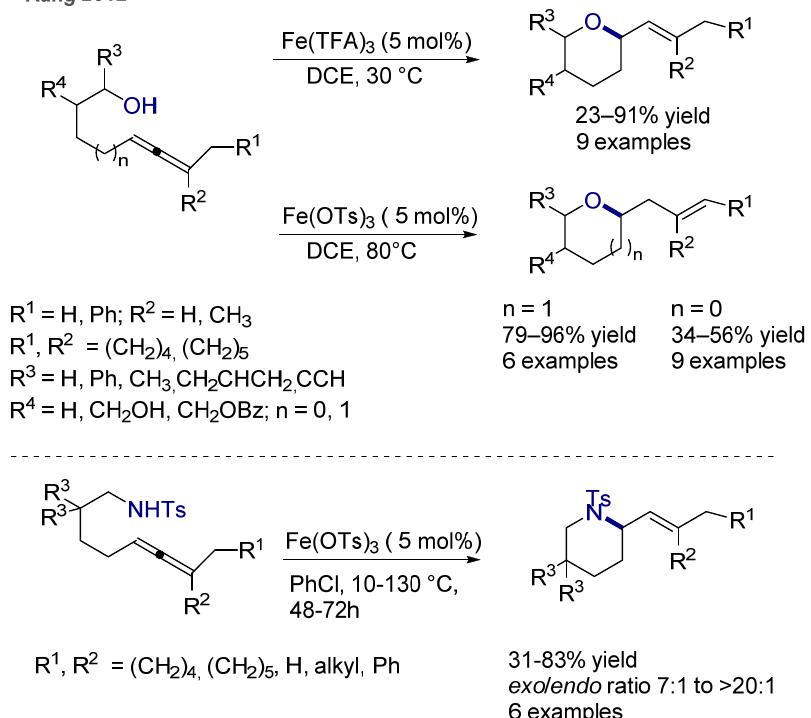
Figure 3. Syntheses of tetrahydropyrans, furans and N -tosyl piperidines from cyclohydrofunction- alization reaction of allenols and allenamides catalyzed by Fe(TFA) 3 and Fe(OTs) 3 .